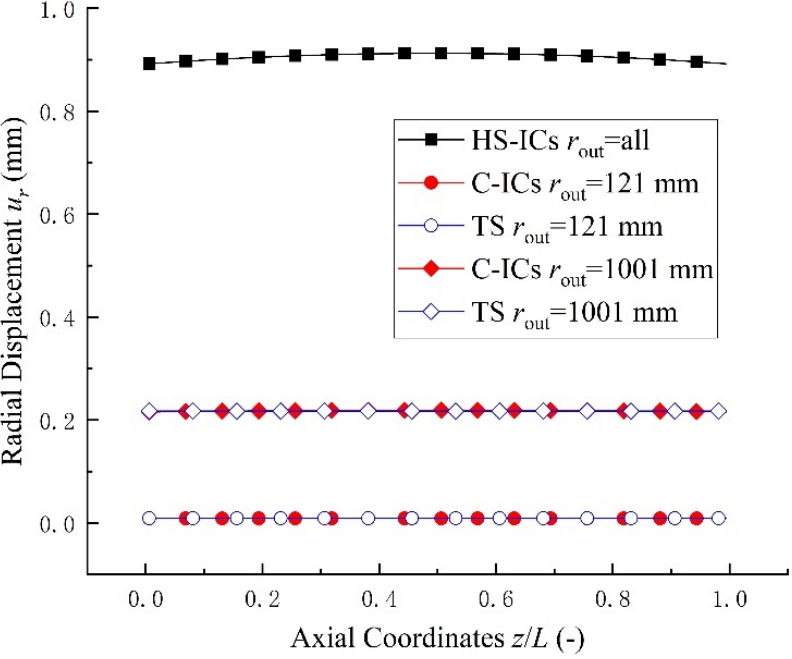
Figure 8. Displacement distribution of a cylindrical shell under unit uniform internal pressure.